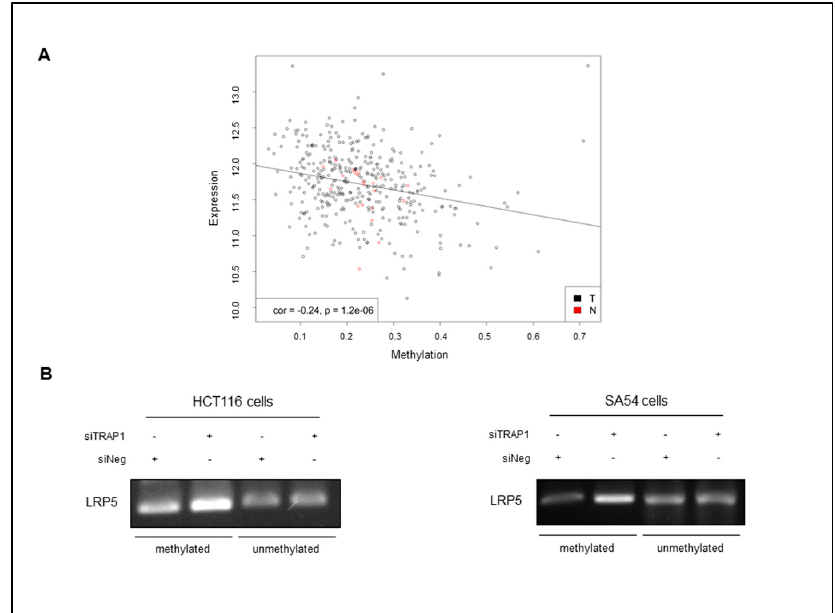
Figure 5. TRAP1 regulates LRP5 expression through DNA methylation mechanisms. ( A ) Scatter plot of 361 TCGA colorectal adenocarcinomas. Promoter methylation is reported on the x -axis, mRNA expression on the y -axis. Solid line shows the linear regression. Rho is the Spearman’s rank correlation and the p -value is the result of the correlation test. ( B ) Methylation-specific PCR representing the level of LRP5 promoter methylation in control (siNeg) TRAP1-silenced (siTRAP1) HCT116 and SA54 cells. PCR analysis of a LRP5 un-methylated region is reported as internal control. 2.5. TRAP1 Is Co-Expressed with Active β -Catenin and LRP5/6 in Human CRCs Table 1. Baseline characteristics of the To address the relevance of TRAP1 regulation on Wnt/ β -Catenin pathway through LRP5/LRP6